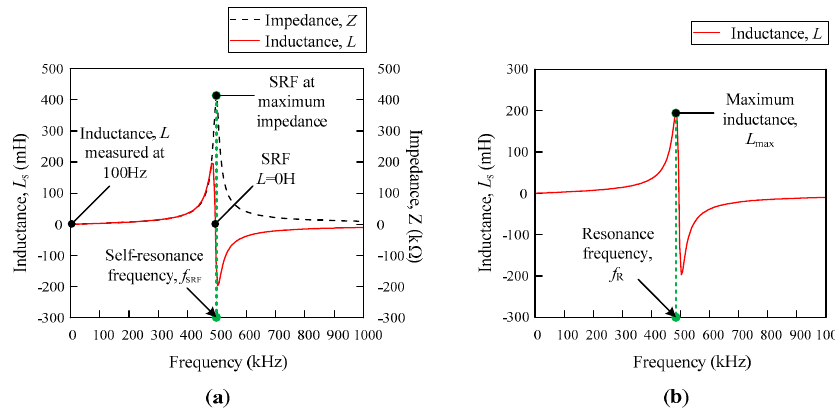
Figure 5. L s –f curve illustrates ( a ) self-resonance frequency (SRF) and ( b ) resonance frequency.